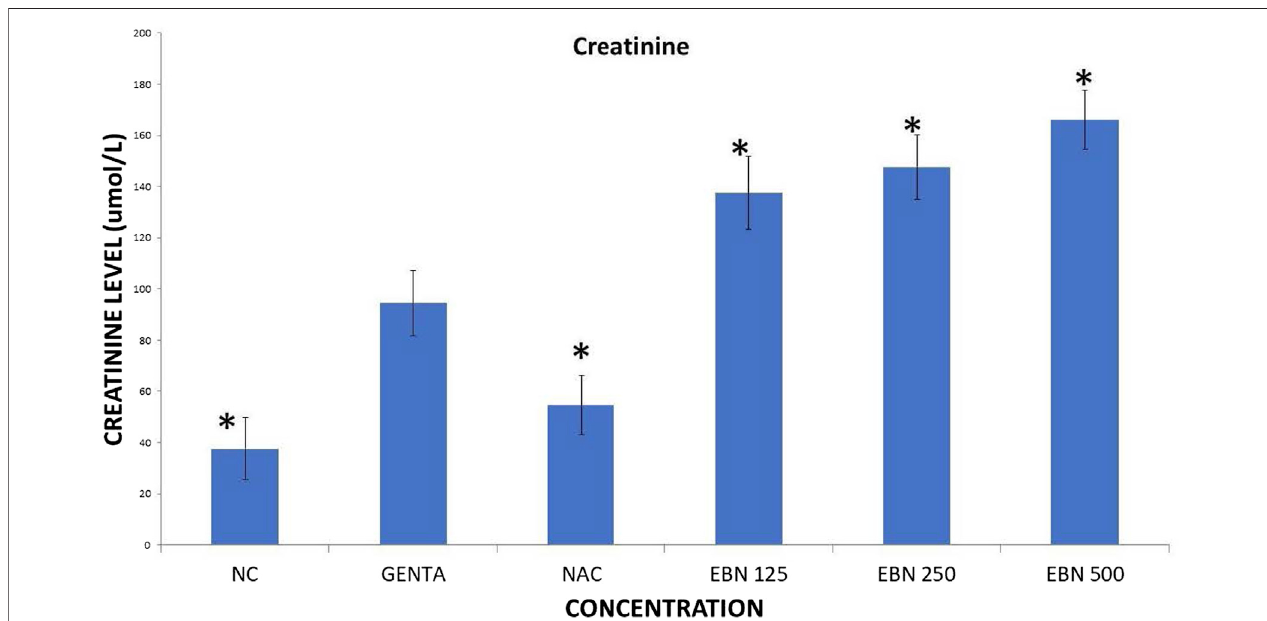
FIGURE 7 | Changes of serum creatinine chnages vs. different pre-treatment group (* p < 0.05 compare to gentamicin group).